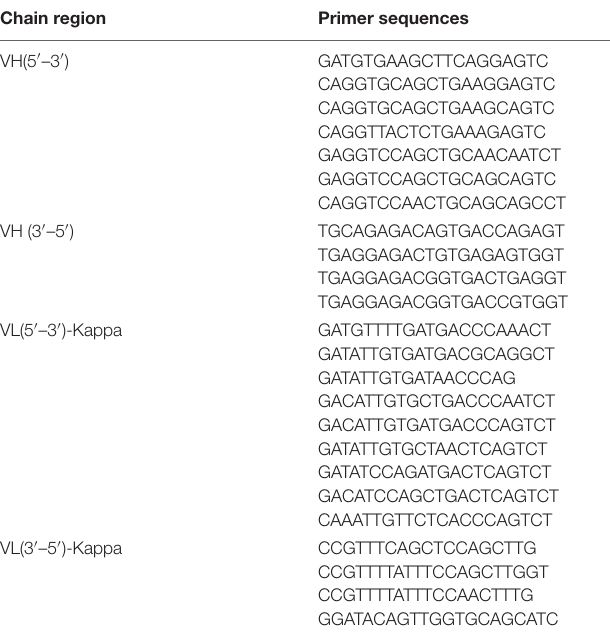
TABLE 1 | Degenerate primers for antibody light and heavy chains. Chain region Primer